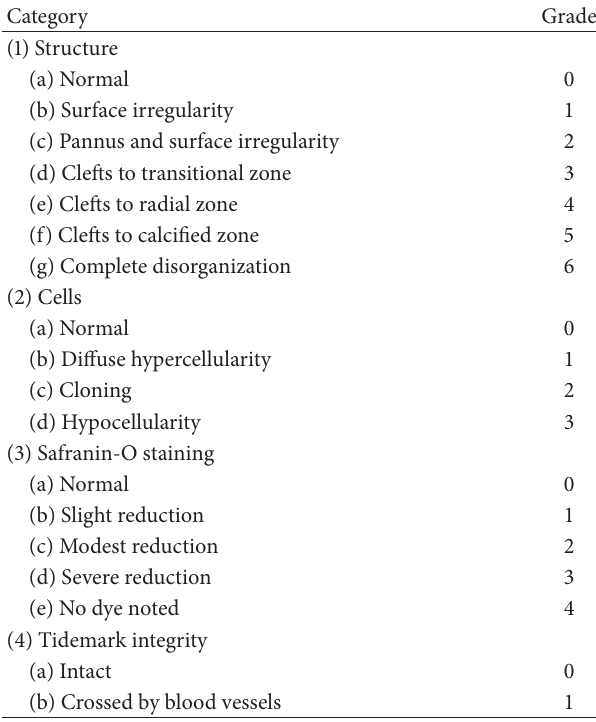
Table 1: Mankin histological grading